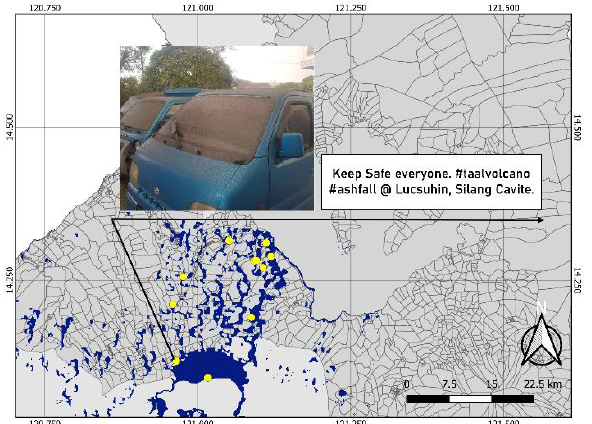
Figure 10. Geocoded tweet within the classified heavy ash reporting ashfall presence in Agoncillo, Batangas